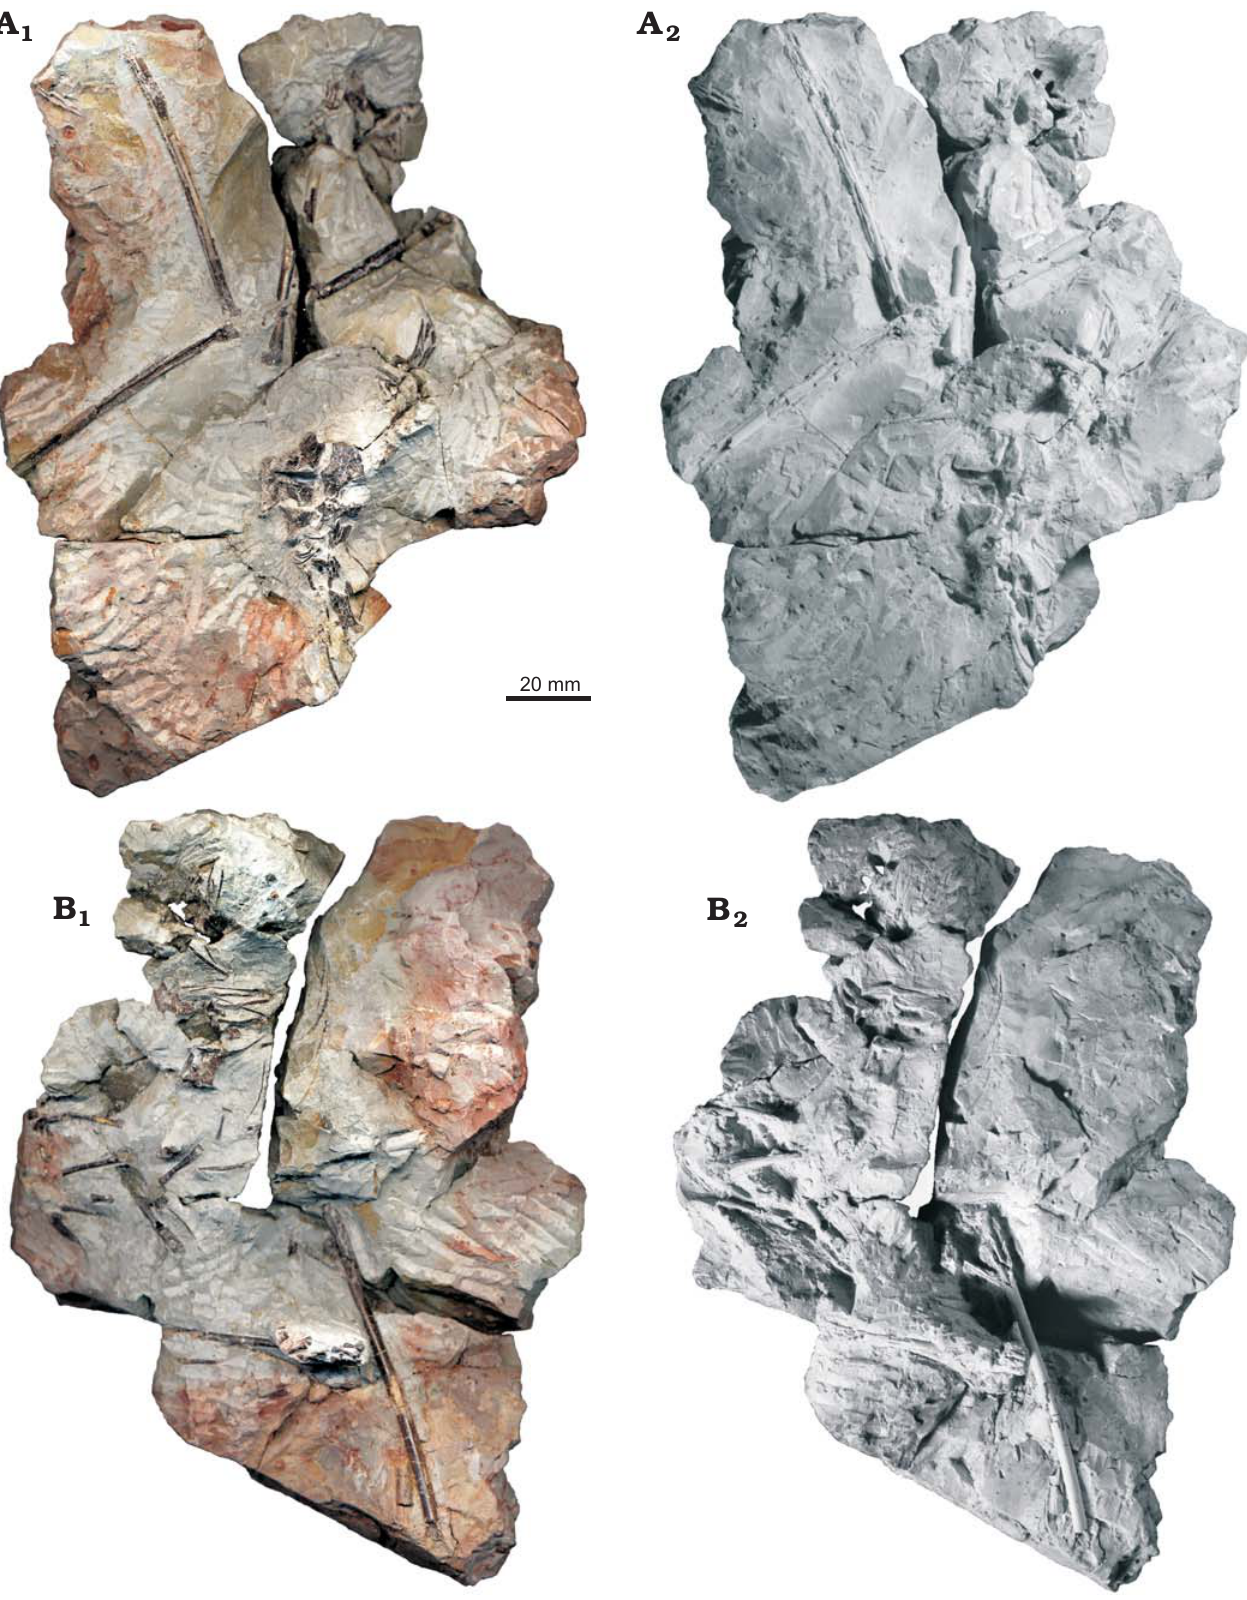
Fig. 5. Partially articulated skeleton ZPAL AbIII/2511 of long-necked reptile Ozimek volans gen. et sp. nov. from Krasiejów, lower Upper Triassic, pre- served in claystone; two slices of the rock ( A , B ). Photographs (A 1 , B 1 ) and specimens coated with ammonium chloride (A 2 , B 2 ). See also explanatory drawing (Fig. 4) and additional photographs (Fig.